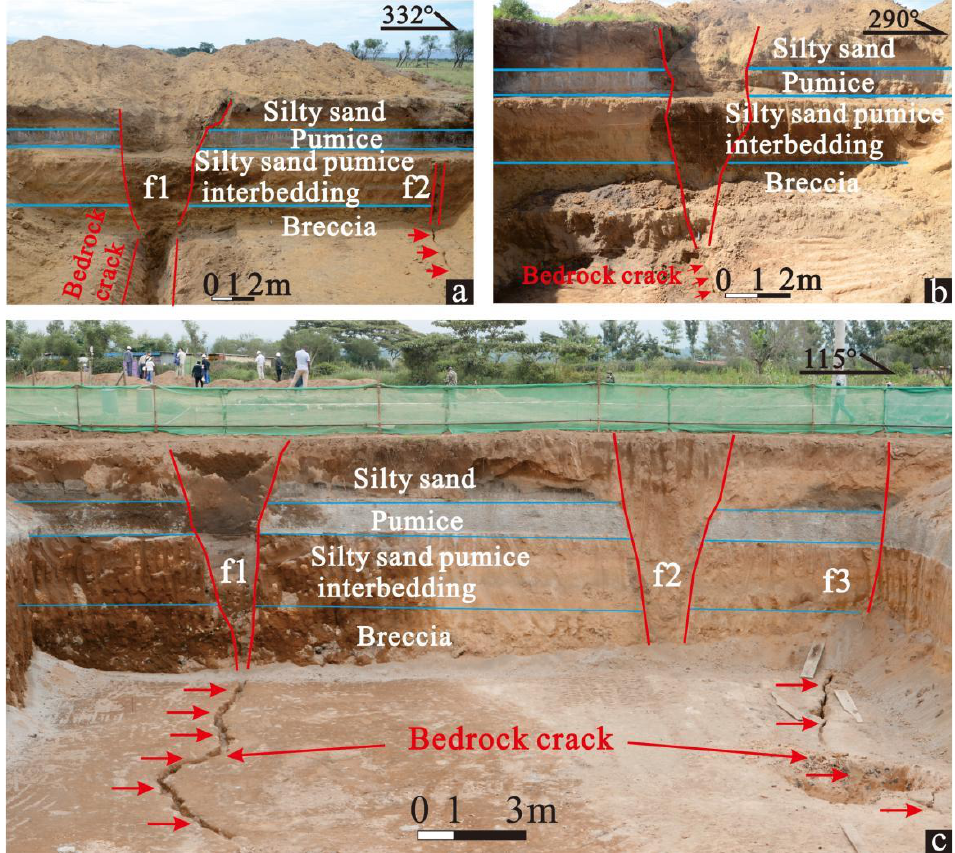
Figure 9. Trench profiles in the Kenya Rift Valley. ( a – c ) correspond to Trenches 1, 2, and 3, respectively. Areas labeled with “f” designate the ground fissures observed in the trenches.